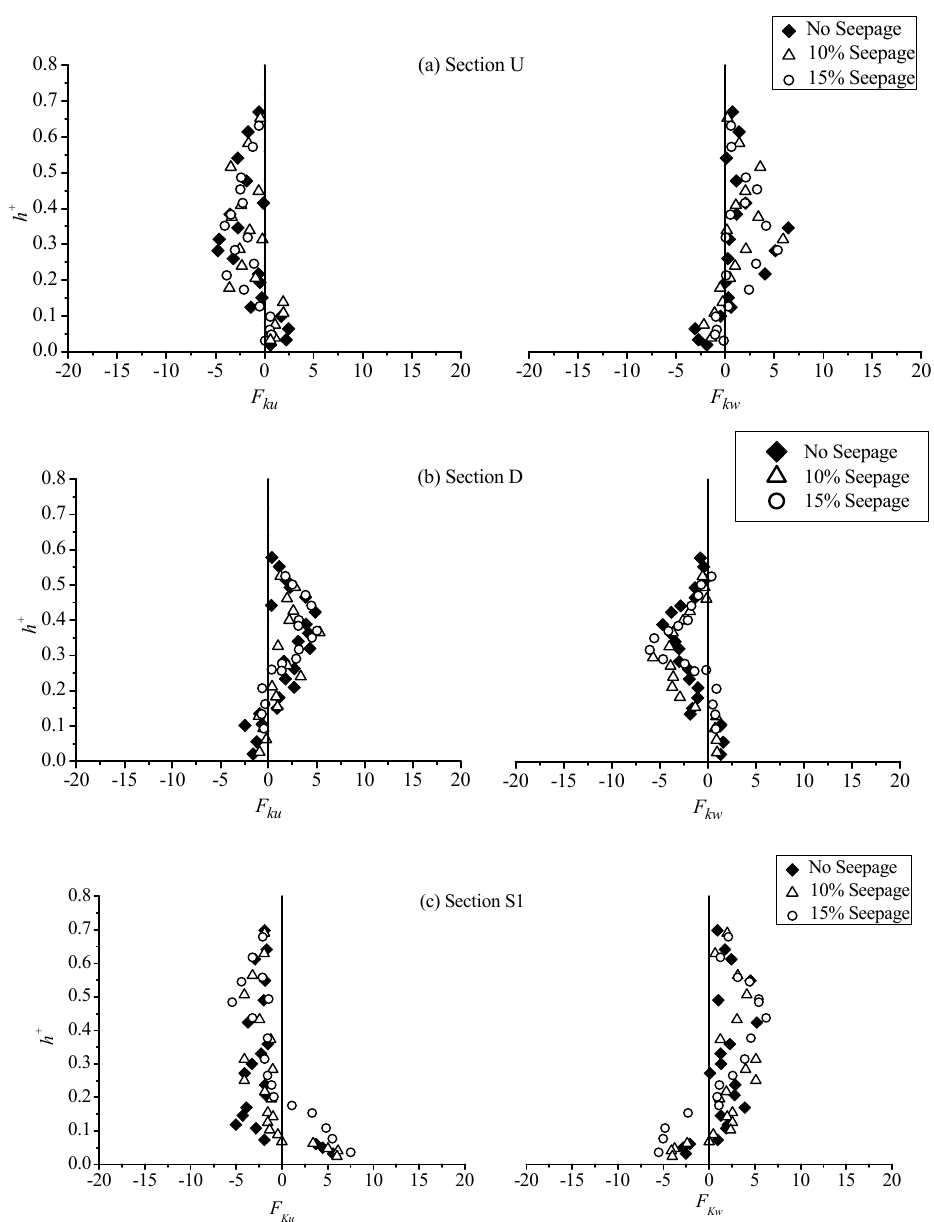
Figure 4. Non-dimensional distributions of turbulent kinetic energy flux (TKE-flux) in the following sections: ( a ) U; ( b ) D; ( c ) S1.